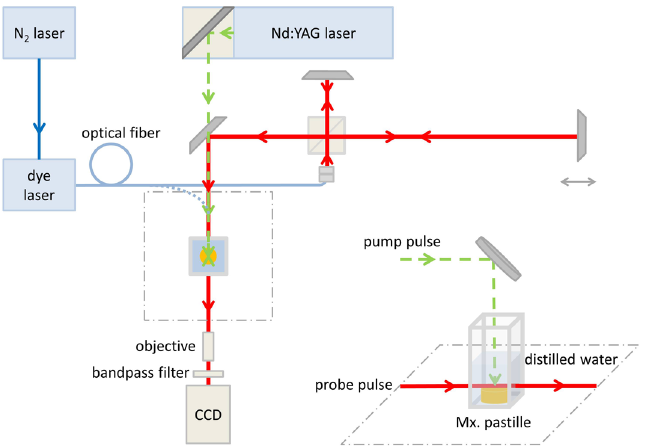
Figure 2. Pump-probe setup for fast photography with direct probe illumination (blue dotted line) or extended with a Michelson interferometer for double exposition with two probe